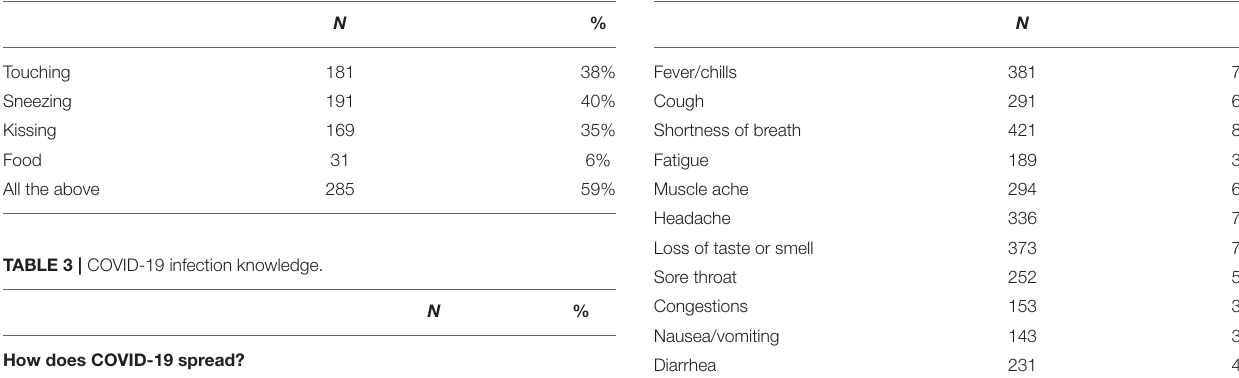
TABLE 4 | What are the symptoms of